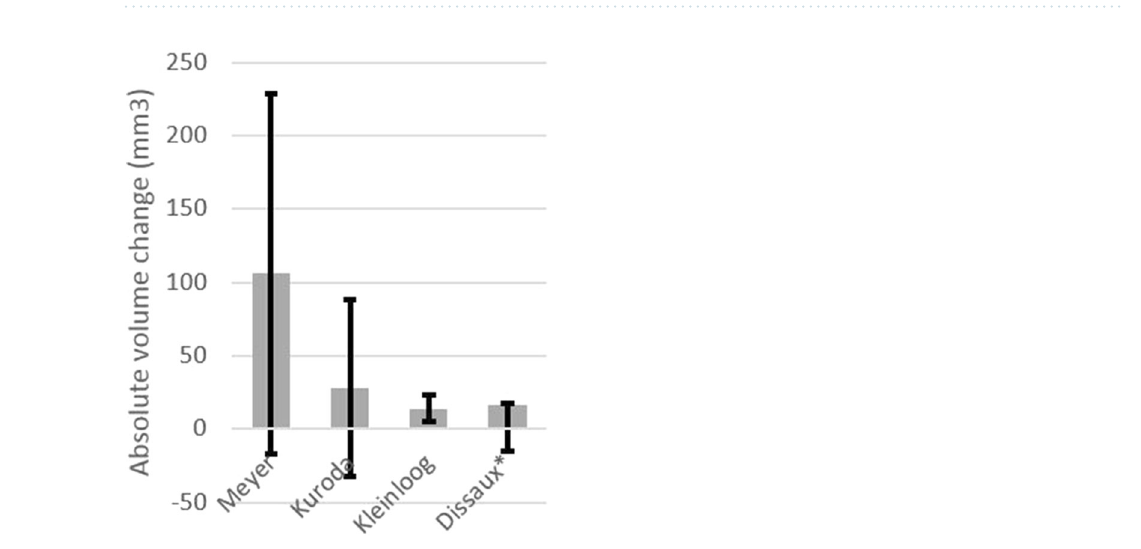
Figure 2. Mean relative volume change per study. Black error bars indicate the standard deviation. *The error bars represent the 95% CI-interval.